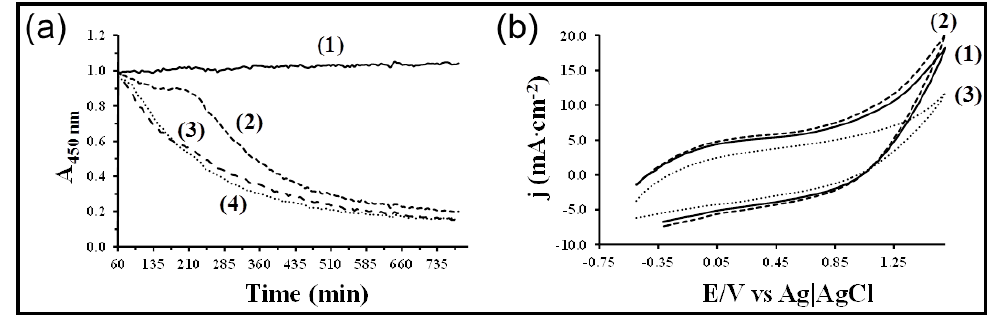
Figure 31. ( a ) Enzymatic activity of lysozyme evaluated through degradation of the peptidoglycan of Micrococcus luteus ( i.e. , decay on the 450 nm absorbance) of: PEDOT (control, curve 1); PEDOT coated with lysozyme (curve 2); PEDOT/lysozyme composite (curve 3) and free lysozyme (curve 4); ( b ) Control voltammograms of PEDOT (curve 1);